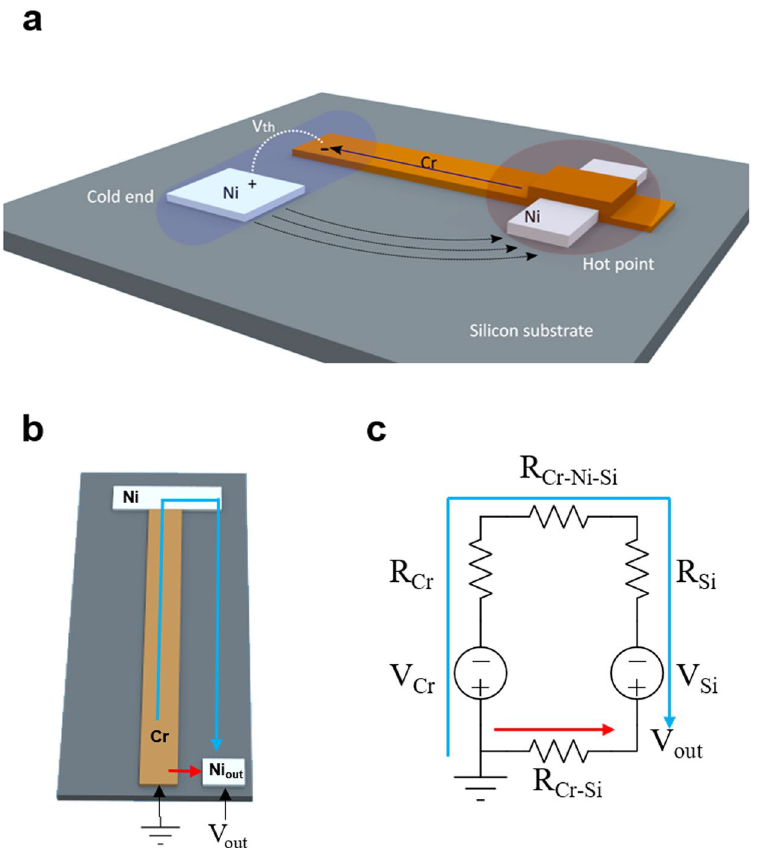
Figure 1. ( a ) Overview of the thermocouple structure. The thermally generated voltage (V th ) is measured at the cold end. The chrome strip forms a Schottky barrier and stays electrically isolated from the silicon substrate except at the hot point where the rectangular nickel pad forms a conductive ohmic contact and connects the chrome arm electrically to the silicon substrate only at the hot point, forming the chrome-silicon junction, resulting in a chrome-on-silicon thermocouple that makes the excellent use of the silicon’s large Seebeck coefficient while keeping the fabrication process simple. ( b ) Overall schematic of the thermocouple with the involved current path drawn on it. The colored arrows indicate the current path. ( c ) Equivalent resistive circuit for the chrome-on-silicon thermocouple in ( b ) to study their effects on the final Seebeck coefficient. The colored arrows indicate the current paths and the voltage measured between the points is a weighted average of the voltage change on each path. The blue arrow corresponds to the ideal current path leading to the highest output voltage consisting of the sum of the two Seebeck voltages. The red arrow corresponds to the very lossy current path leading to no voltage output (R Cr : the resistance of the Cr arm; R Si : the resistance of the silicon between the measurement point and the pad; R Cr-Si : the isolation resistance of the Schottky barrier between the Cr arm and the silicon; R Cr-Ni-Si : the resistance of the Ni ohmic contact pad between the chromium and silicon arm; V out : the output voltage measured at the pads; V Cr : the Seebeck voltage contributed by the chromium arm; and V Si : the Seebeck voltage contributed by the